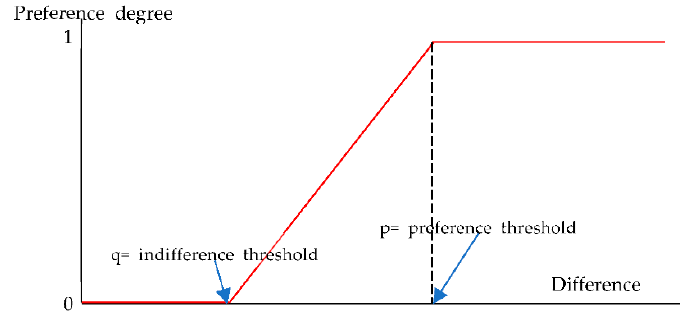
Figure 4. The preference threshold and indifference threshold.